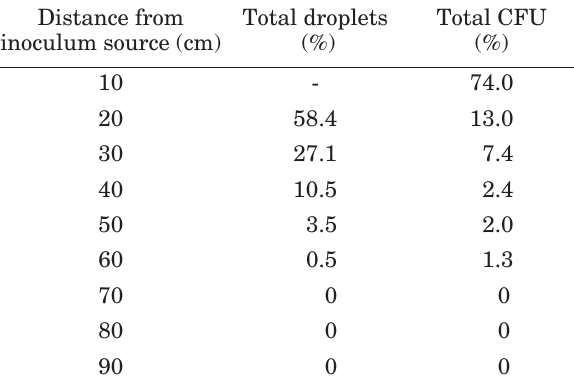
Table 3. Percentage of droplets and CFUs of Pseudomonas syringae pv. c oriandricola collected on King’s B medium at different distances from the source of splash